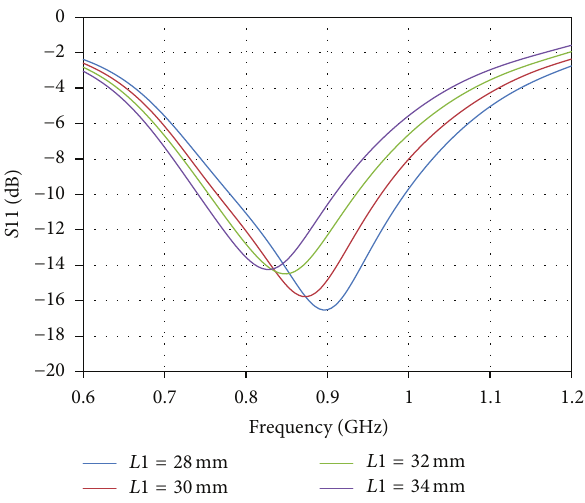
Figure 3: Parametric study on the influence of 𝐿1 .